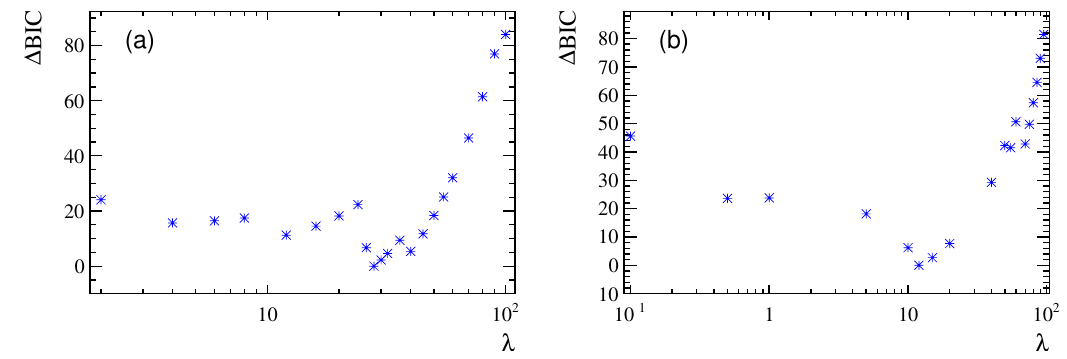
Figure 5 . Di(cid:11)erence in the BIC value from its minimum as function of the LASSO parameter (cid:21) for D 0 ! (cid:25) + (cid:25) (cid:0) (cid:25) + (cid:25) (cid:0) (a) and Stage 1 D 0 ! K + K (cid:0) (cid:25) + (cid:25) (cid:0)